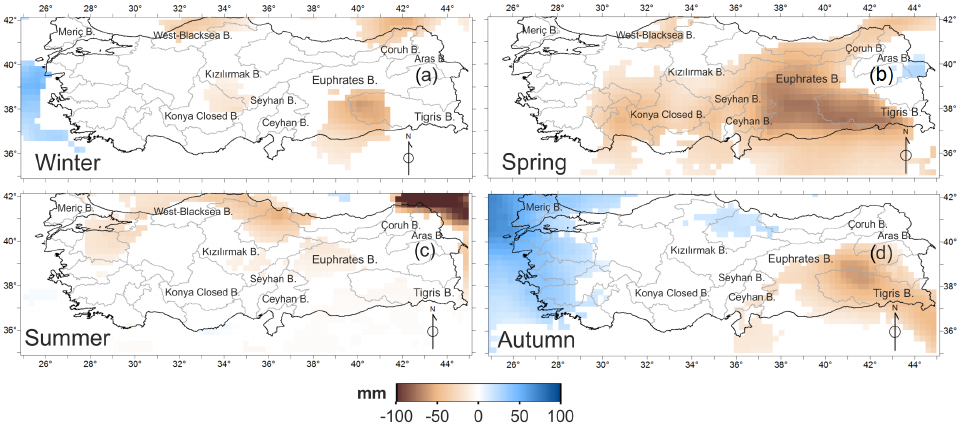
Figure 5. The magnitudes of the total precipitation trends (32-year total) by ERA-Interim for (a) winter, (b) spring, (c) summer and (d) au- tumn. Only the areas with significant trends ( p <0.1) are shown on each map. The polygons in each figure delineate the 26 water basins in the